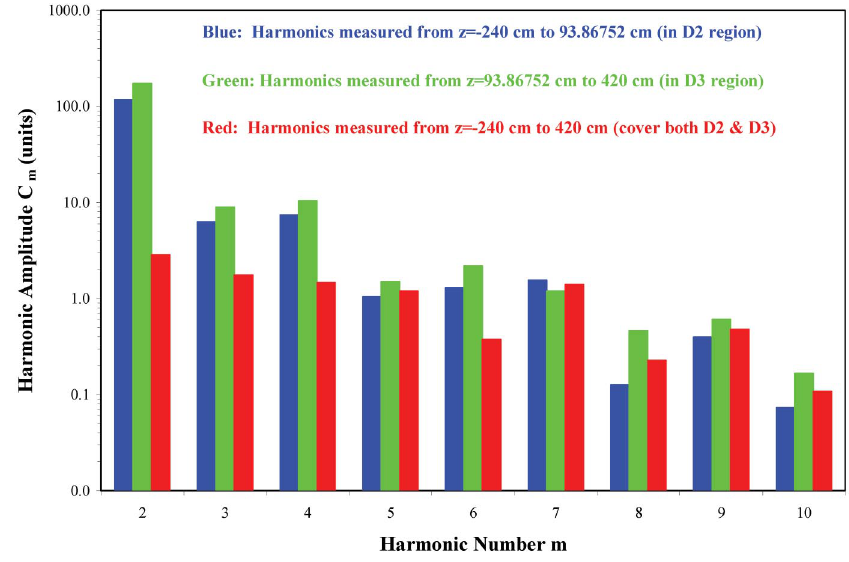
FIG. 4. (Color) Integrated harmonic amplitude of chicane dipoles D2 and